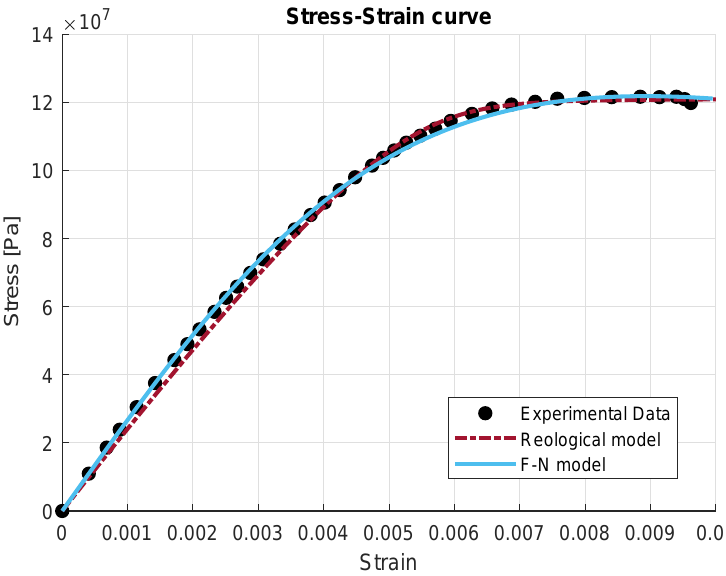
Figure 3. Stress-Strain curve obtained with the García et al. model in a tensile test.